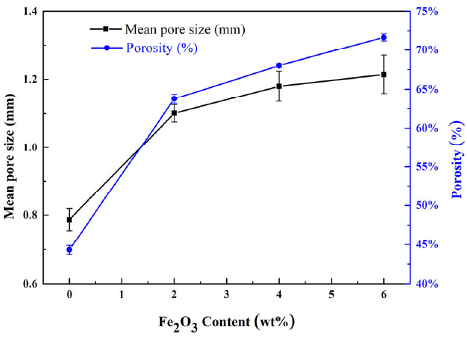
Figure 12. Mean pore size and porosity of samples with different Fe 2 O 3 contents at 1200 ◦ C for 20